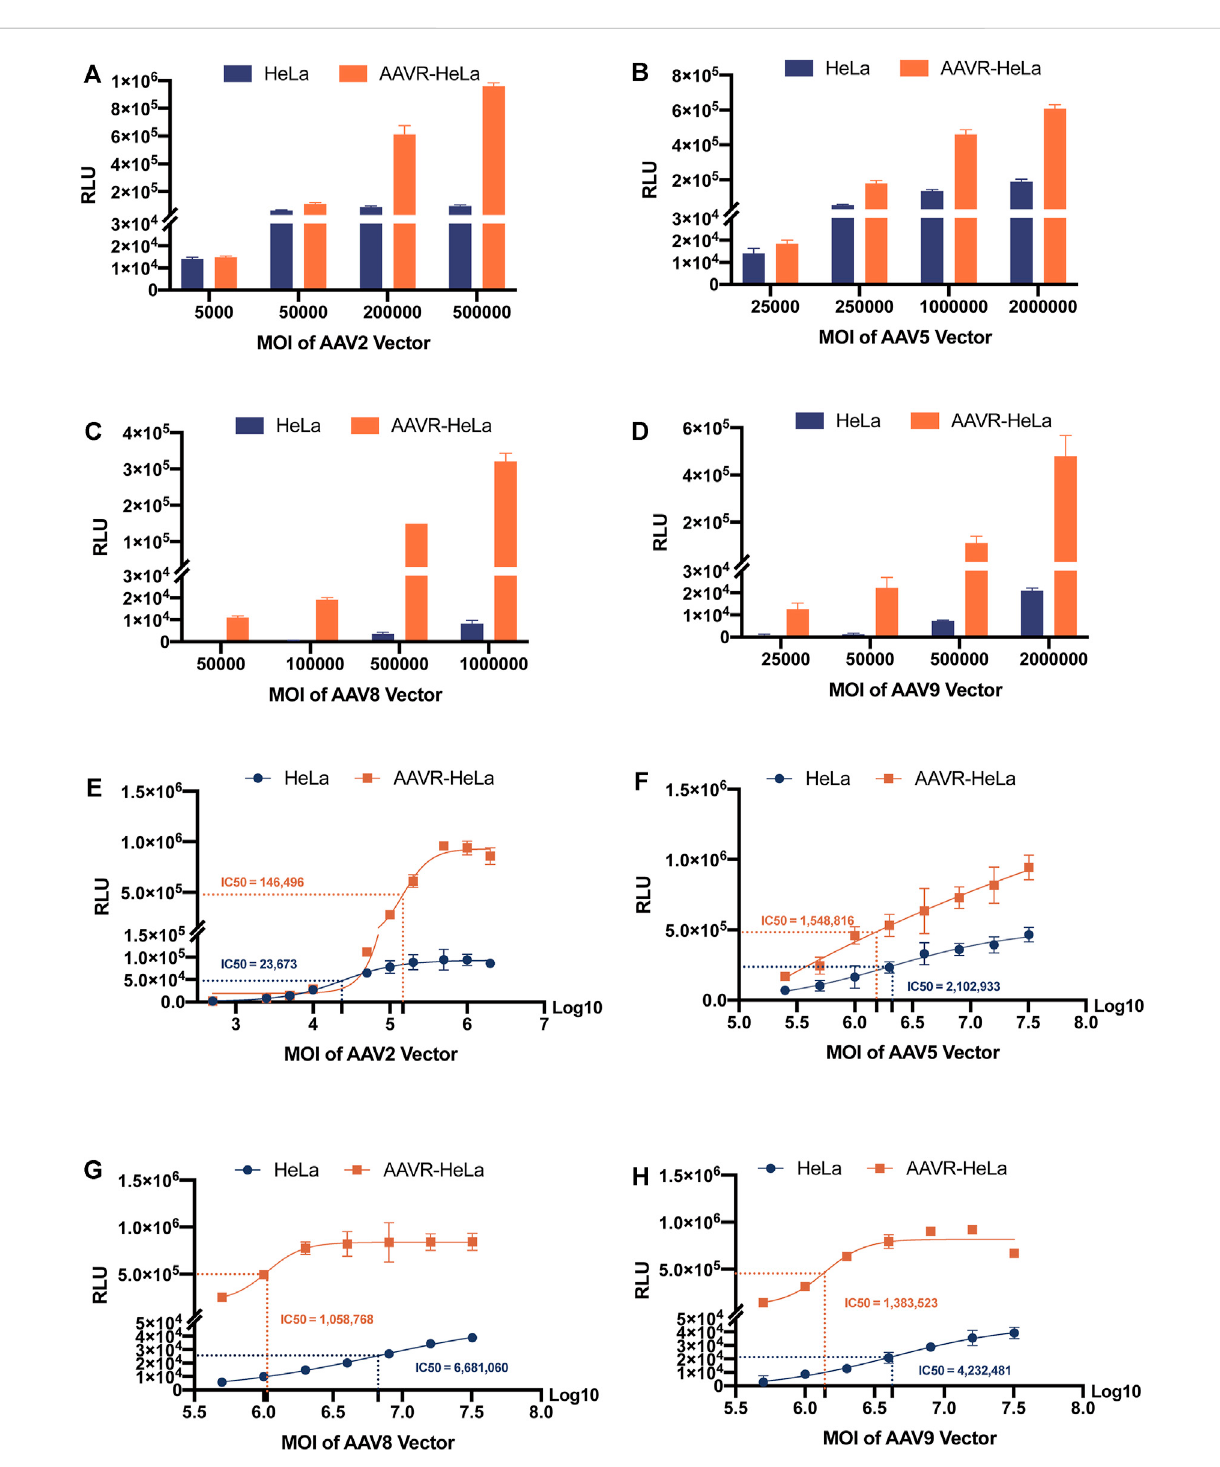
FIGURE 5 RLU measurements from HeLa and AAVR-HeLa cells infected by rAAV-Luc vectors with different serotypes at variable MOIs. Cells were seeded and infected by rAAV-Luc vectors at the indicated MOIs. Cells were collected at 48 h post-infection and RLUs were measured. For RLU values that did not reach a plateau using MOIs as high as possible under the conditions in this study, the IC 50 values were given as the AAV MOIs reaching half of the highest RLU values. The results were presented as mean ± SD ( n = 3). RLU measurements at different MOIs using rAAV-Luc vectors with different serotypes including AAV2 (A) , AAV5 (B) , AAV8 (C) , and AAV9 (D) . RLU measurements for IC 50 calculations using rAAV-Luc vectors with different serotypes including AAV2 (E) , AAV5 (F) , AAV8 (G) , and AAV9 (H)